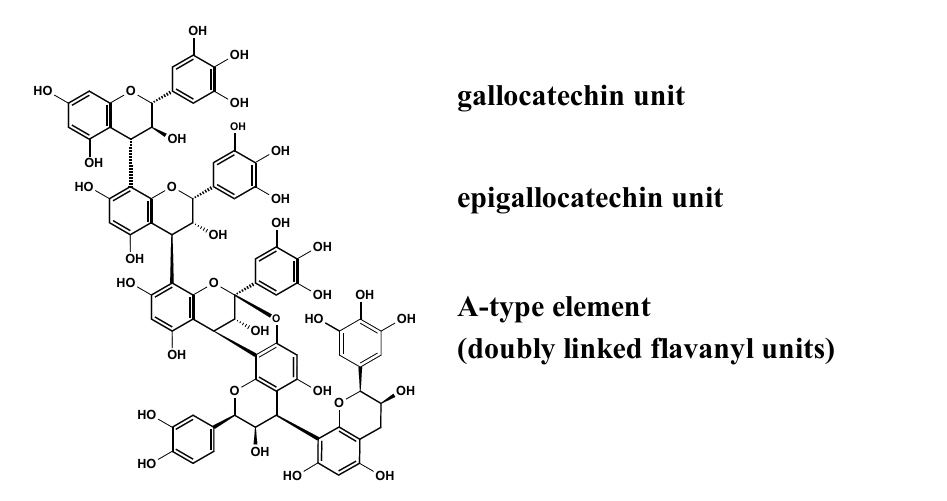
Figure 2. Representative structure of the proanthocyanidins of Pelargonium sidoides with epigallocatechin and gallocatechin extender units as well as doubly linked A-type elements.